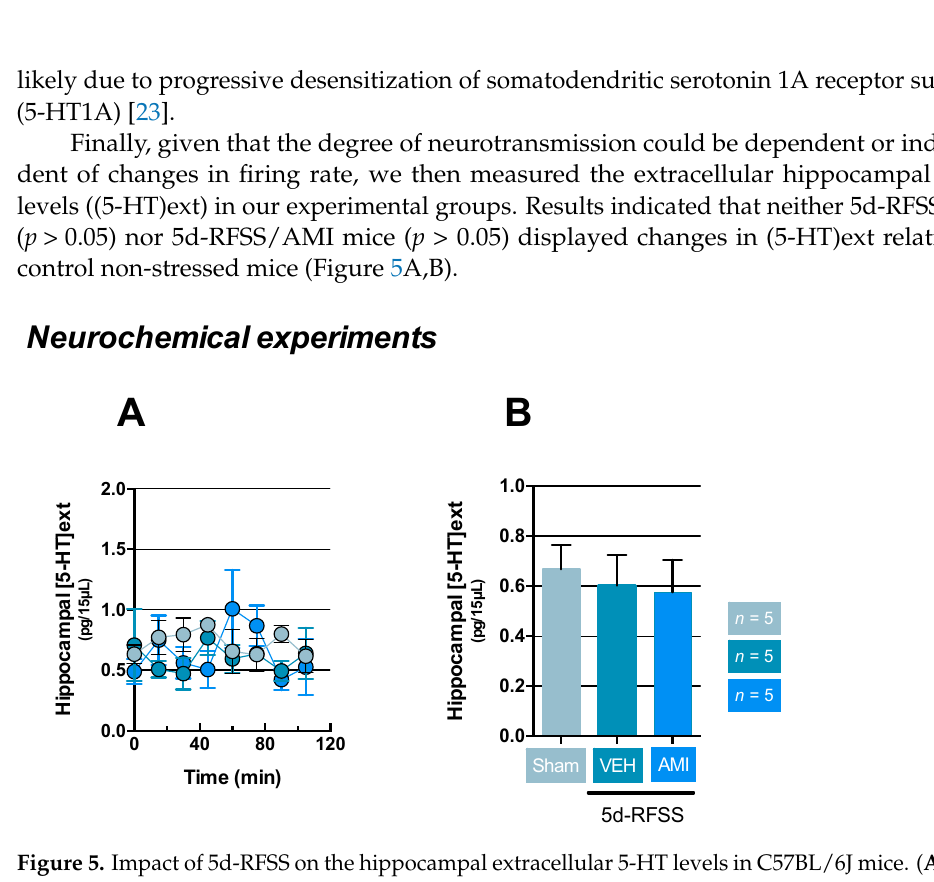
Figure 5. Impact of 5d-RFSS on the hippocampal extracellular 5-HT levels in C57BL/6J mice. ( A , B ) Intracerebral microdialysis experiments. Time course of the amount of 5-HT outflow collected during 0–120 min expressed in pg/15 µL ( A ). Data are means ± SEM of the amount of hippocampal 5-HT outflow. One-way ANOVA did not show significant effect of treatment factor (F(2,12) = 0.13; p = 0.87] ( B ). n = 5 mice per group.